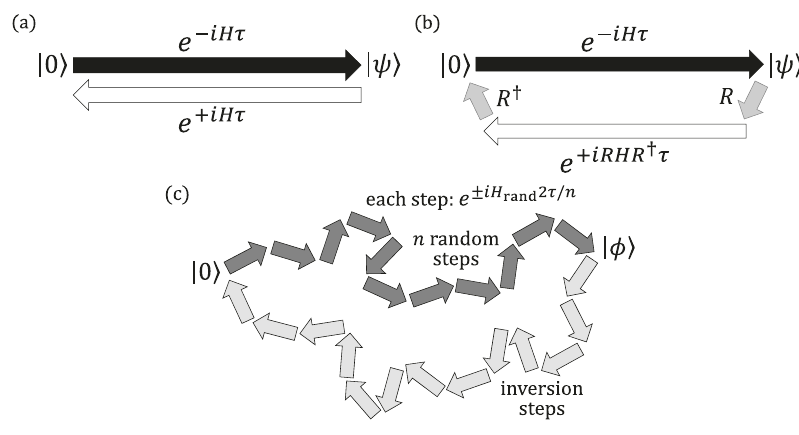
Fig. 1 Illustration of veri fi cation protocols for analog quantum simulators. Various protocols yield information about the accuracy of a quantum simulator by propagating a state along a closed loop and verifying to what degree the system returns to its original state, labeled here as 0 j i . The state ψ j i denotes the state of the system after applying the dynamics of Hamiltonian H for a time τ , whereas the state ϕ j i denotes an arbitrary state. a Time-reversal analog veri fi cation: Running an analog simulation forward in time, followed by the same analog simulation backward in time. b Multi-basis analog veri fi cation: Running an analog simulation forward in time, rotating the state, performing the backward simulation by an analog version in the rotated basis, and fi nally rotating the state back. c Randomized analog veri fi cation: Running a random sequence of subsets of the Hamiltonian terms (denoted as H rand ), followed by an inversion sequence of subsets of the Hamiltonian terms which has been calculated to return the system approximately to a basis